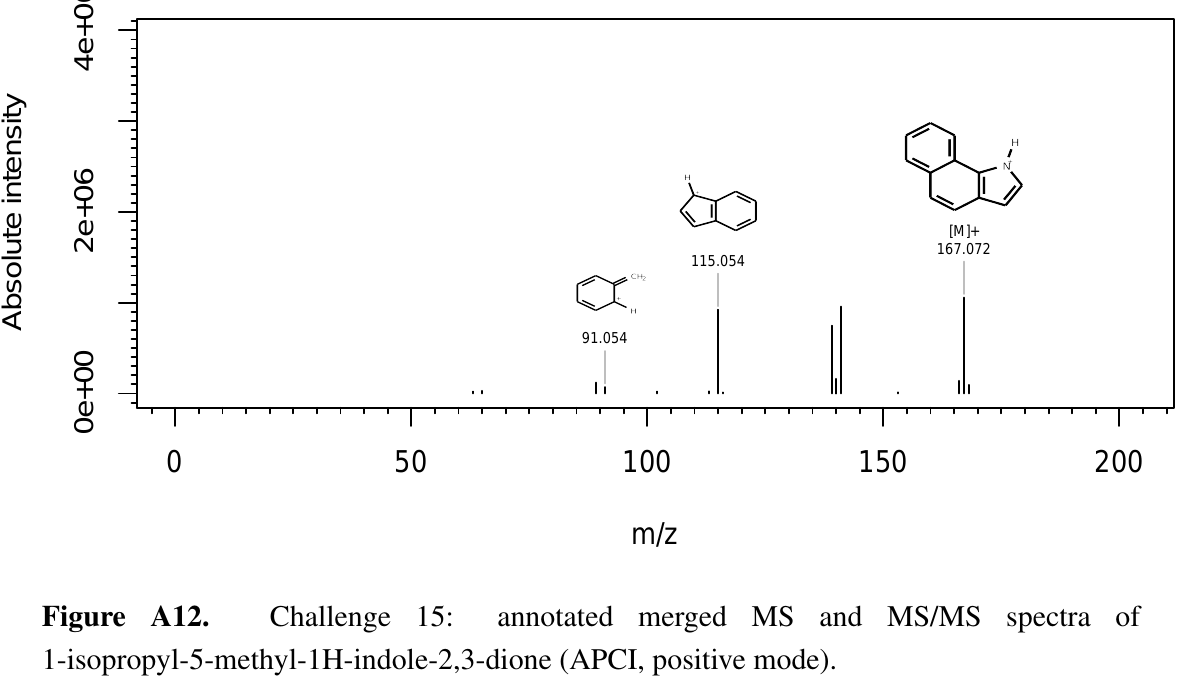
Figure A11. Challenge 14: annotated merged MS/MS spectra of 1H-benz[g]indole (APCI, positive mode).